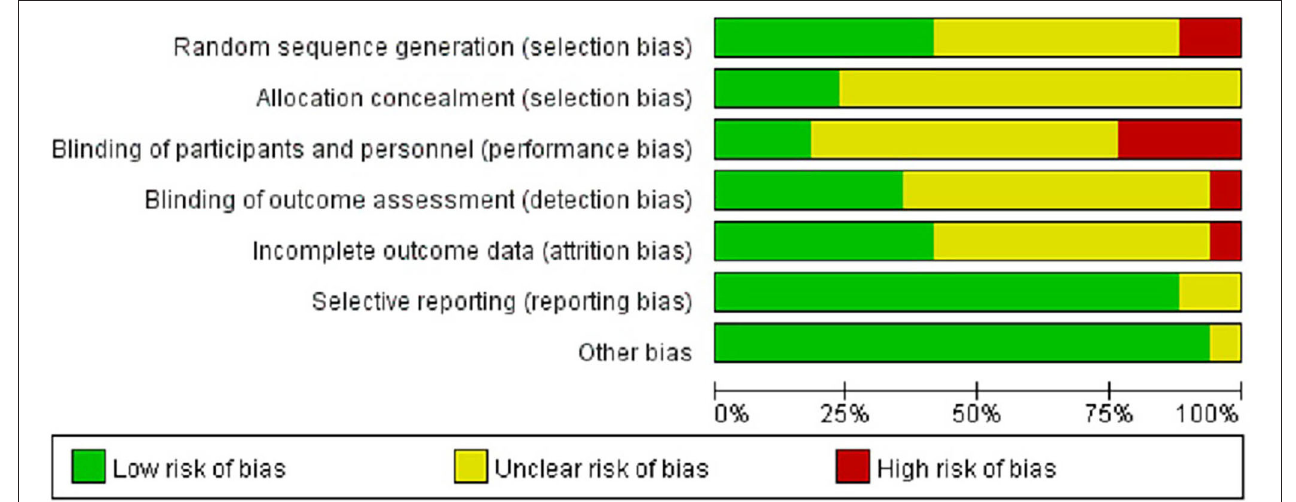
FIGURE 2 | Evaluation of the risk of